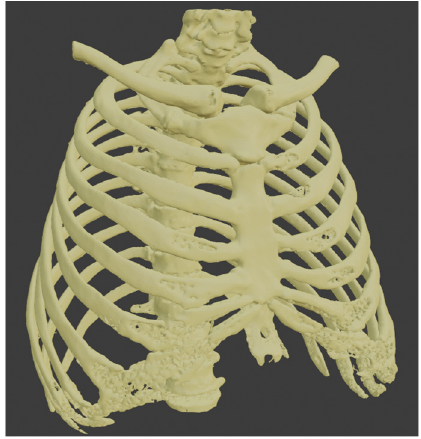
Figure 7. Segmentation of the bones.